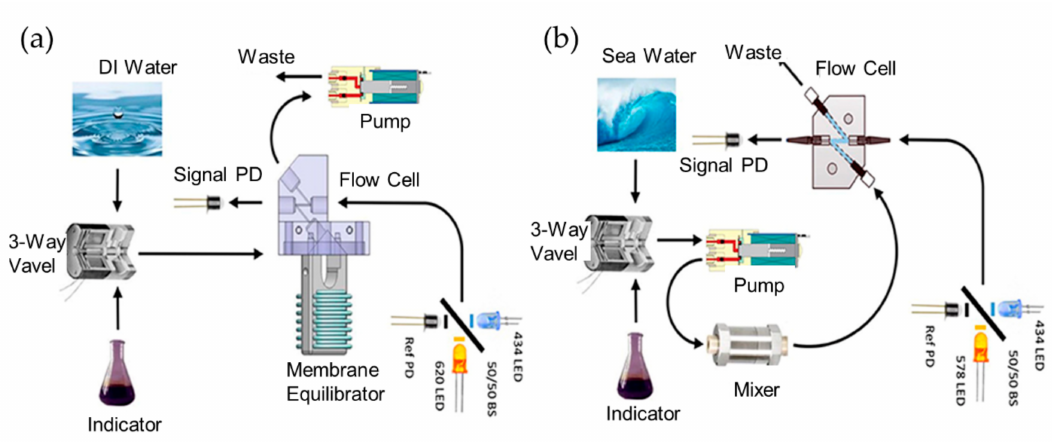
Figure 6. ( a ) Schematics of the detection system for SAMI-CO 2 . ( b ) Schematics of the detection system for SAMI-pH. Images reproduced from